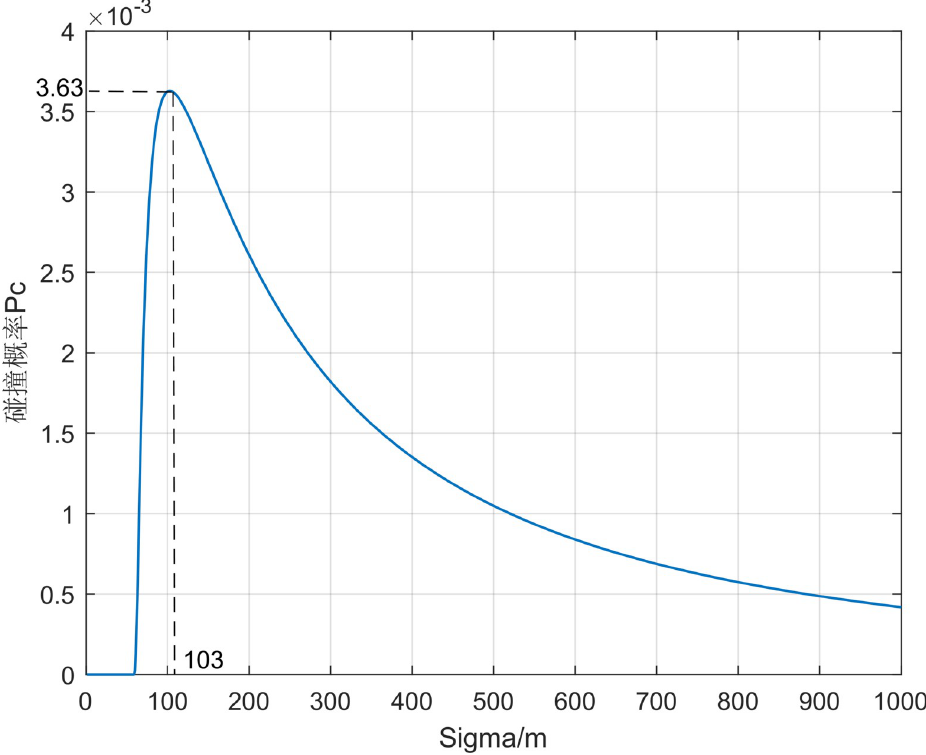
Fig 9. P c values with σ x changing when σ x : σ y : σ z = 1:1:1.